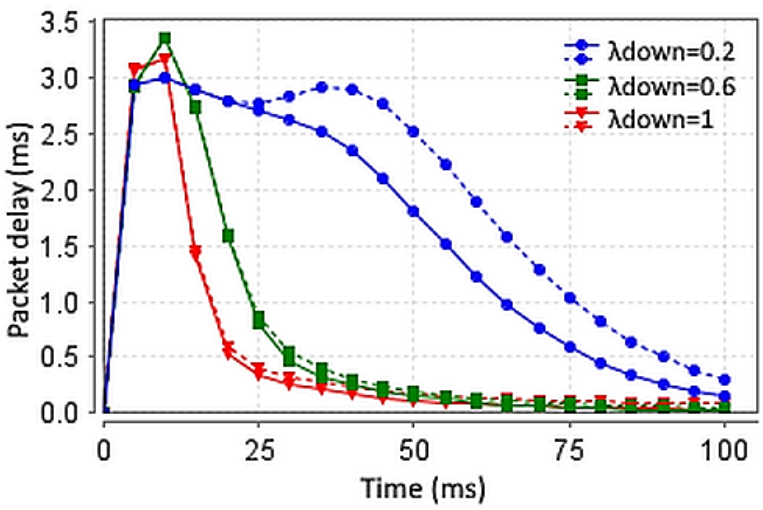
Figure 12. Packet delay for different d timeout values. d timeout = 35 ms (solid line), d timeout = 10 (dotted